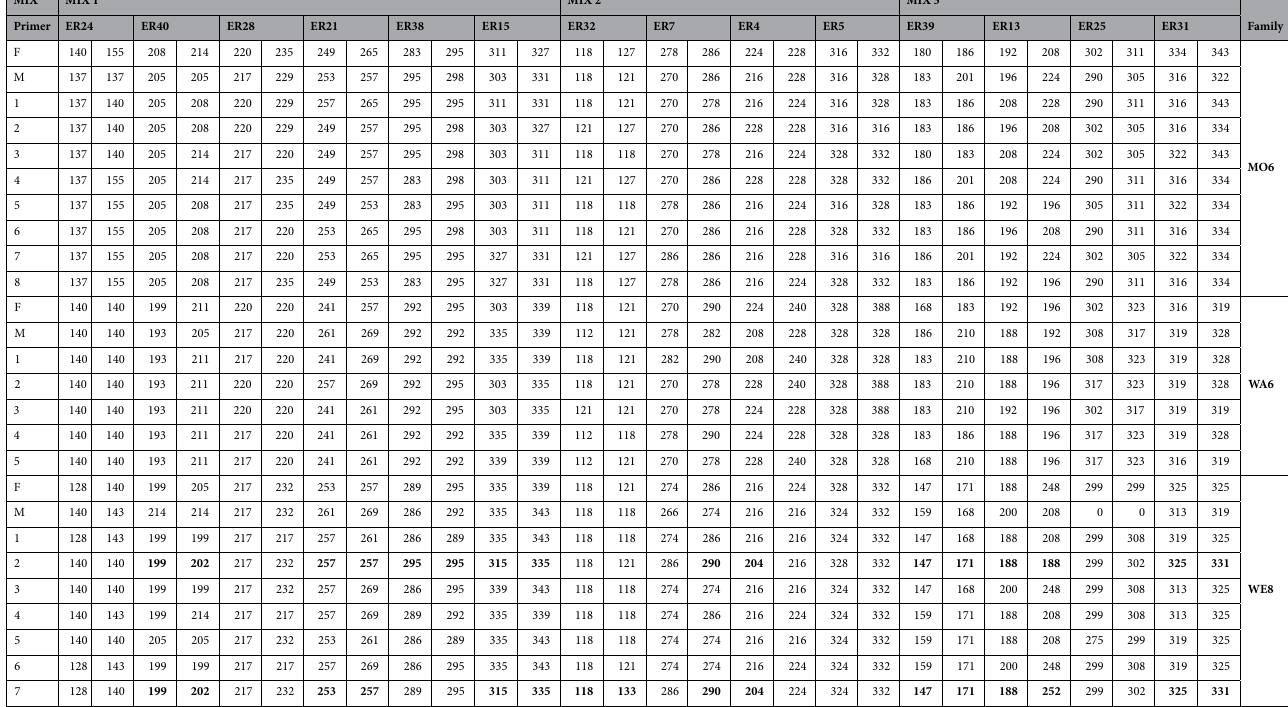
Table 3. Microsatellite genotypes of members of three full families of the European Robin. Example of families MO6 and WA6 confirm Mendelian manner of inheritance of investigated loci. Family WE8 shows detection of extra-pair paternity within the brood. Genotypes shown in bold suggest genetic contribution of an ‘extra’ male. F—female, M—social male,